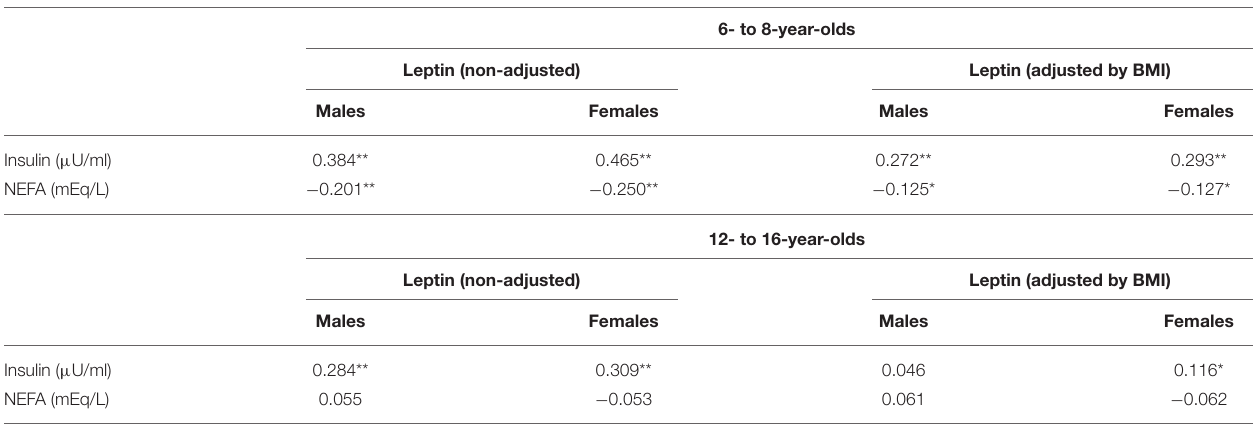
TABLE 2 | Correlation analysis of leptin with insulin and NEFA, non-adjusted and adjusted by BMI in 6- to 8-year-old and 12- to 16-year-old males and